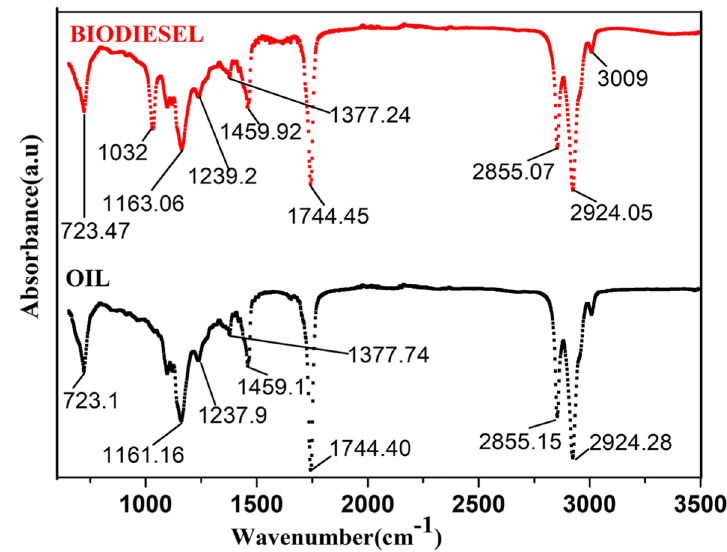
Fig. 13 FTIR spectra of biodiesel and